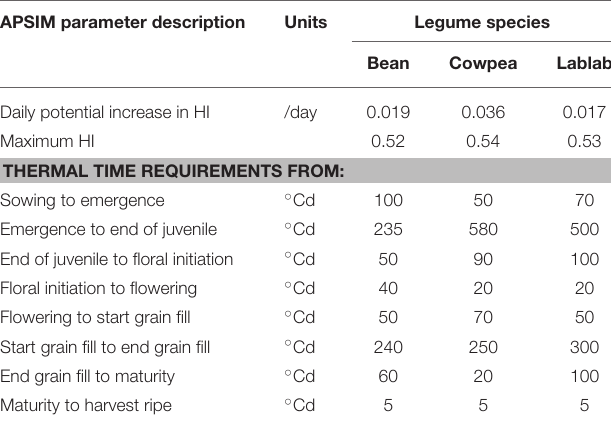
TABLE 7 | Cultivar-specific parameters for different short-season grain legume species common bean, cowpea, and lablab use to calibrate the Agricultural Production Systems sIMulator